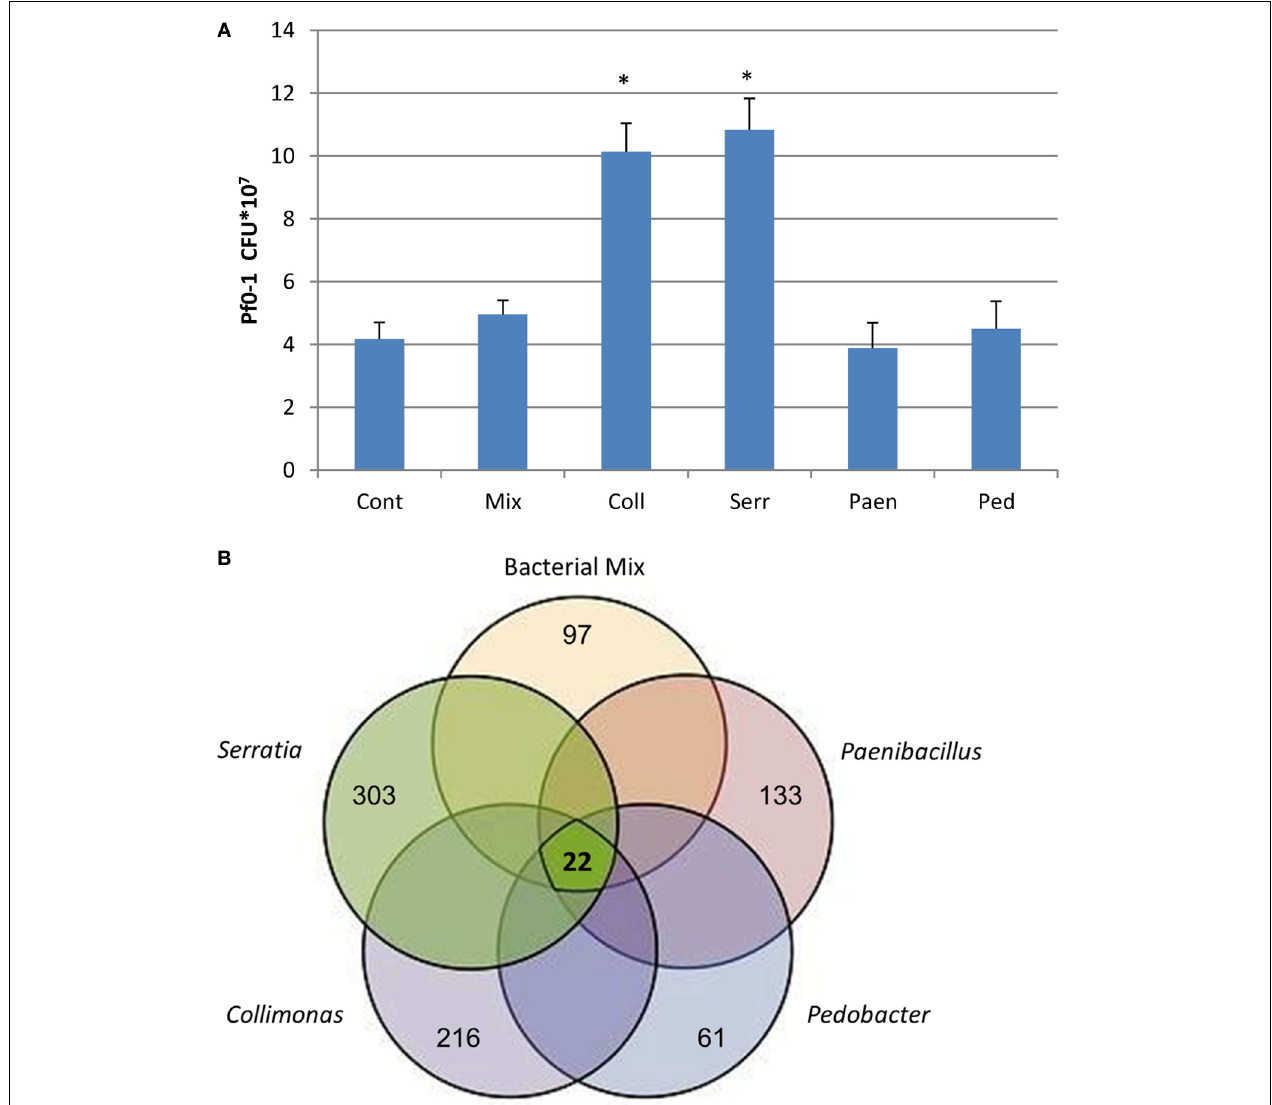
FIGURE 2 | (A) Number of P. fluorescens Pf0–1 colony forming units (CFUs) developed after 3 days of incubation on water-agar while exposed to volatiles emitted by different bacteria growing in sand containing artificial root exudates: Coll- Collimonas pratensis Ter 91; Serr- Serratia plymuthica PRI-2C; Paen- Paenibacillus sp. P4; Ped- Pedobacter sp. V48 and Mix- mix of all 4 bacteria. Cont- control is sand with artificial root exudates but without bacteria. Inoculation density of P. fluorescens Pf0–1 is 5 . 0 × 10 6 cells. Presented data are means of three replicates, error bars indicate standard deviation and *indicates significant differences in CFUs between control and treatments ( P < 0 . 05). (B) Venn diagram representing the number of differentially expressed genes in P.